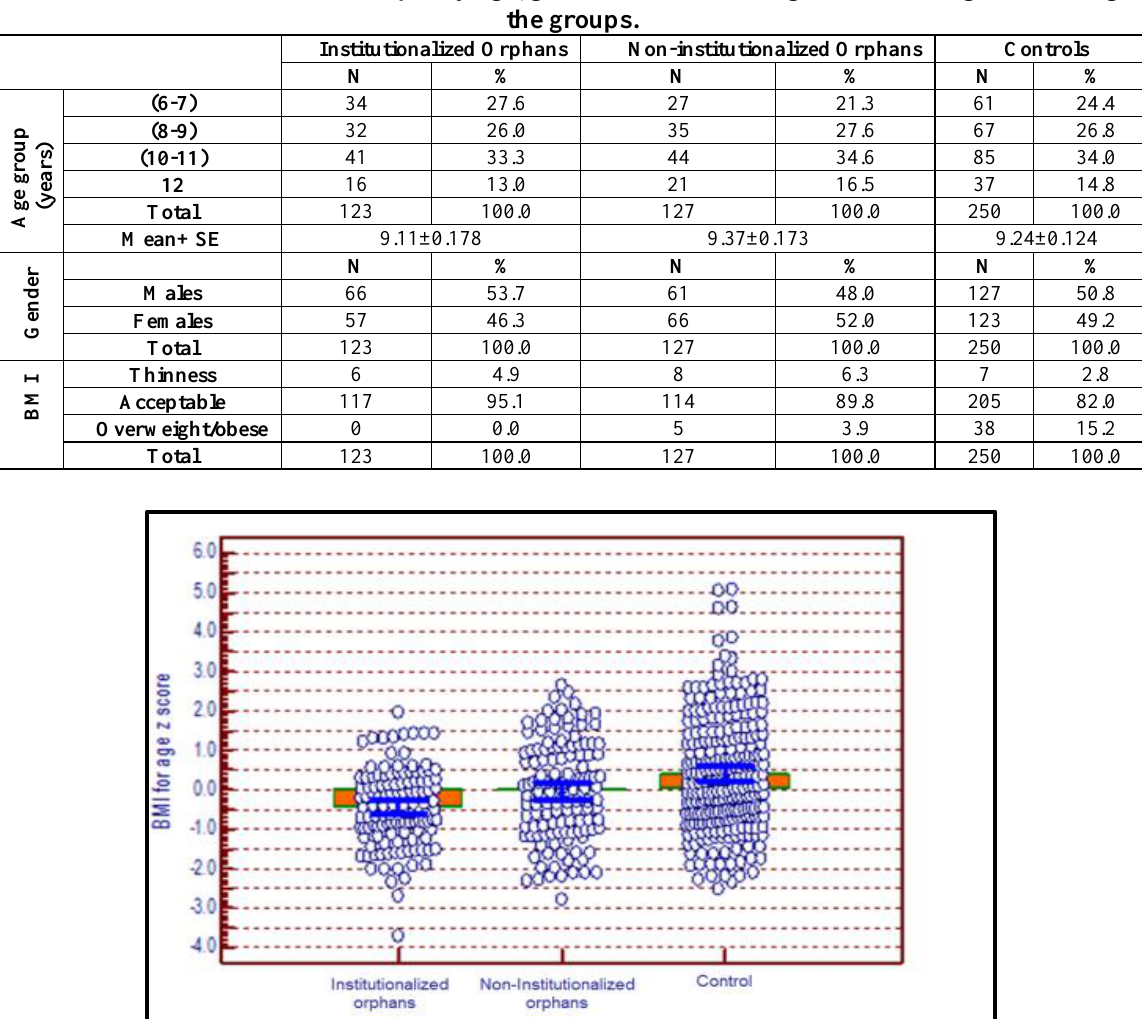
Figure 1: Dot diagram with error bars showing the difference among the 3 groups in mean (with its 95% confidence interval)